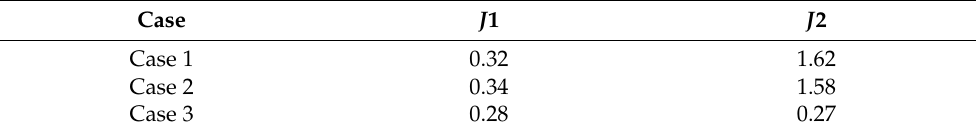
Table 8. Seismic performance evaluation by means of J 1 and J 2.